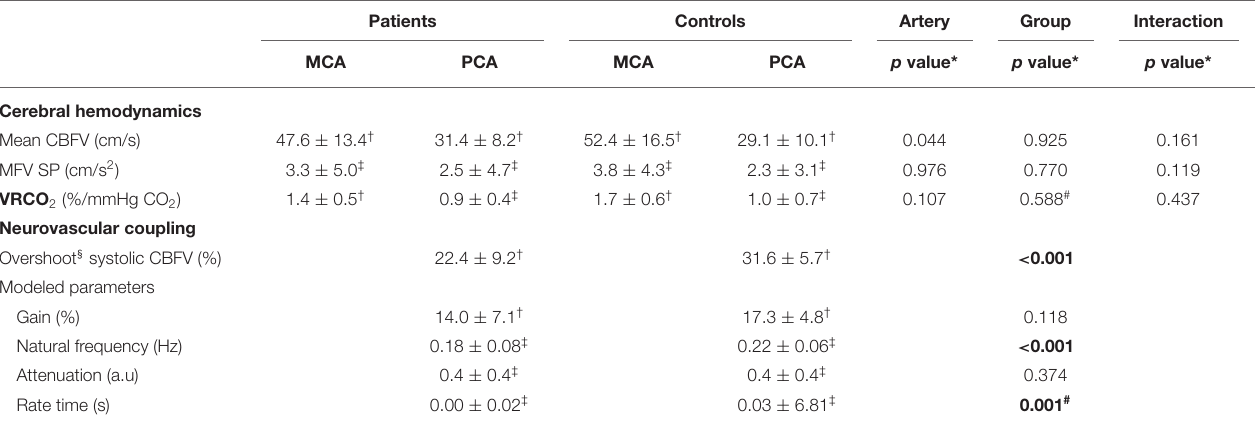
* Two-factor mixed-design ANOVA for the interaction between group variable (patients vs. controls) and arterial territory (MCA vs. PCA), controlling for age and gender. For NVC, values were obtained using an ANCOVA. Effect size: rate time η p ² = 0.174, natural frequency η p ² = 0.237 and overshoot systolic CBFV η p ² = 0.186. || gender significantly interfered with the model; # age significantly interfered with the model; † Values are presented as mean ± standard deviation. ‡ Values are presented as median ± interquartile range. § Maximal CBFV increase during visual stimulation. a.u., arbitrary units; CBFV, cerebral blood flow velocity; VRCO 2 , vasoreactivity to carbon dioxide; MFV SP, median flow velocity spectral power; MCA, middle cerebral artery; PCA, posterior cerebral artery. Bold values of statistically significant p values (p < 0.05). TABLE 3 | Cerebral hemodynamics, VRCO 2 and NVC: controls vs. HT-nDM vs. HT-DM patients, controlled for age and gender.